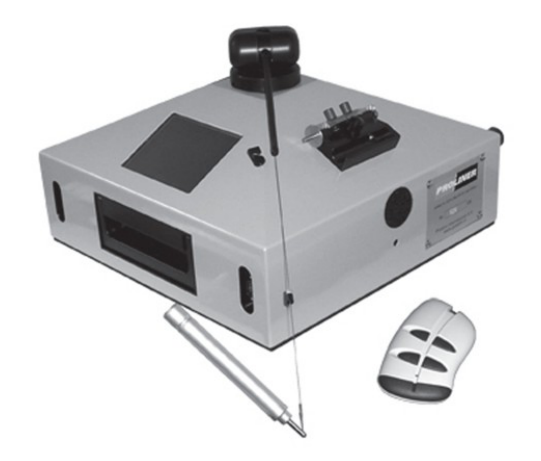
Figure 1. Direct measurement equipment where the central unit and pen joined by cable can be